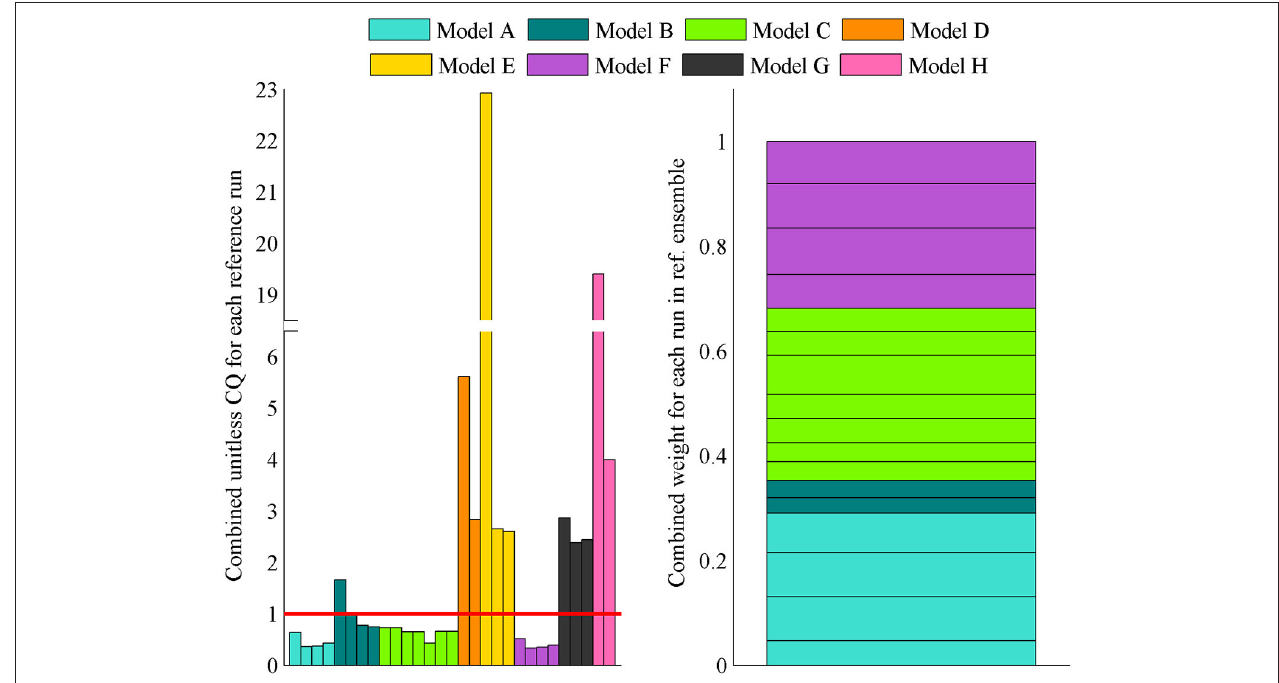
FIGURE 7 | Combined cost function calculated from all variables and stations. Shown are the results for all 29 control simulation of Model A to